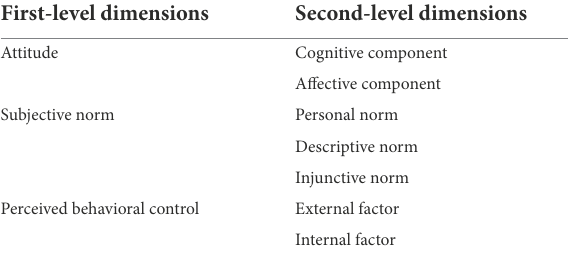
TABLE 2 The dimensions of employee fraud